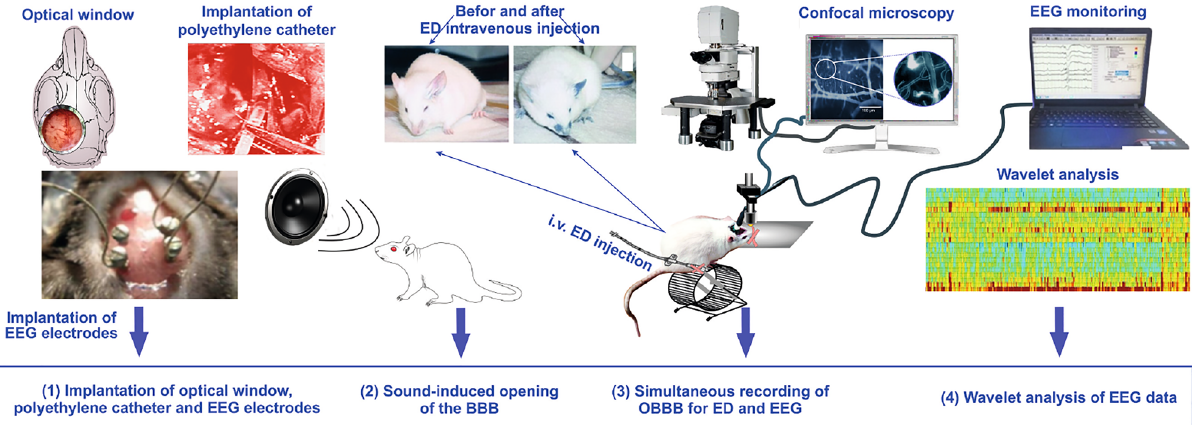
Figure 1. Schematic illustration of design of experiments: (1) optical window, polyethylene catheter and EcoG electrodes were implanted; (2) ten days afterward, registration of ECoG1; rats were underwent to the intermittent sound (100 dB, 370 Hz) during 2h (60 sec sound and 60 sec—pause); (3) 60 min sound-off, we performed in vivo real time fluorescent microscopy of the BBB opening for ED (i. v.), which we detected as bright fluorescence around the cerebral microvessels; (4) when the optical signs of ED leakage were detected, ECoG2 recordings were performed during 60 min; (5) the control rats decapitated and their brains were collected for confirmation of the BBB opening for ED using confocal microscopy; two day afterward, registration of ECoG3; (6) ECoG recordings were collected and analyzed using CWT approaches. The final collages were generated using the licensed program Colel Draw X8 (https://www.coreldraw.com).